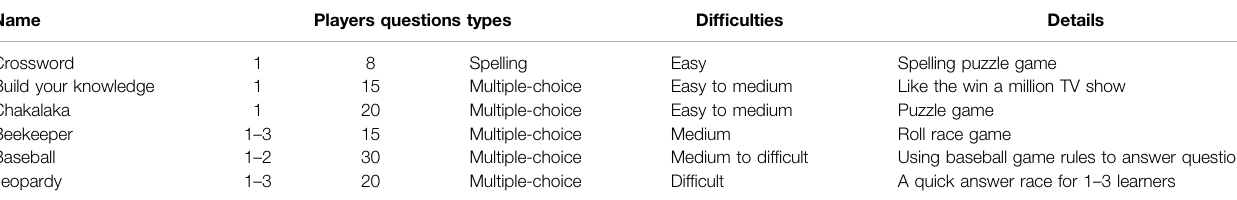
TABLE 2 | Summary table of the selected WISC-Online